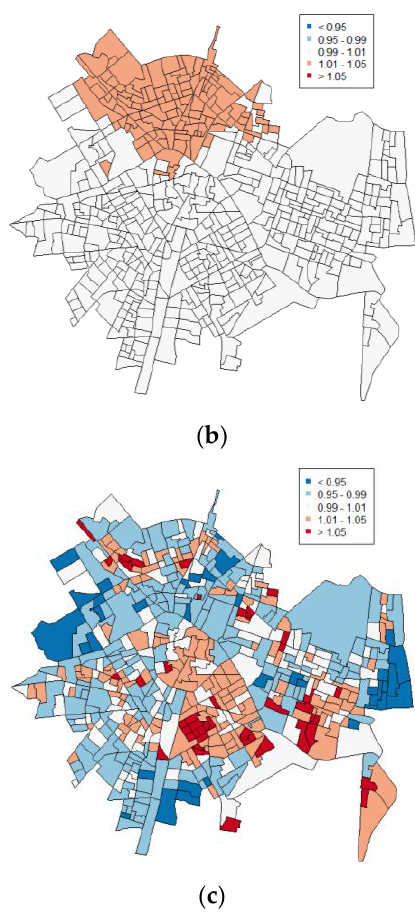
Figure 1. ( a ) Change in off-premise density from 2010 to 2015; ( b ) change in restaurant/cafe density from 2010 to 2015; and ( c ) change in bar density from 2010 to 2015.